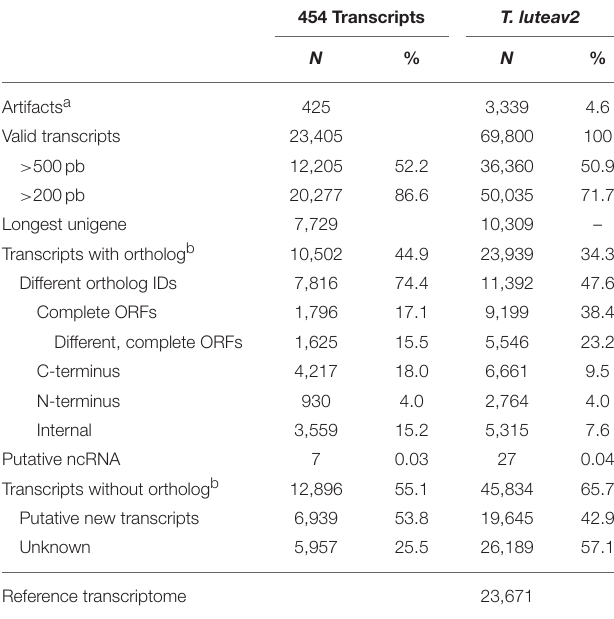
TABLE 2 | Overview of quality parameters for assembled long-reads (454 transcripts) and final T.luteav2 transcriptome.